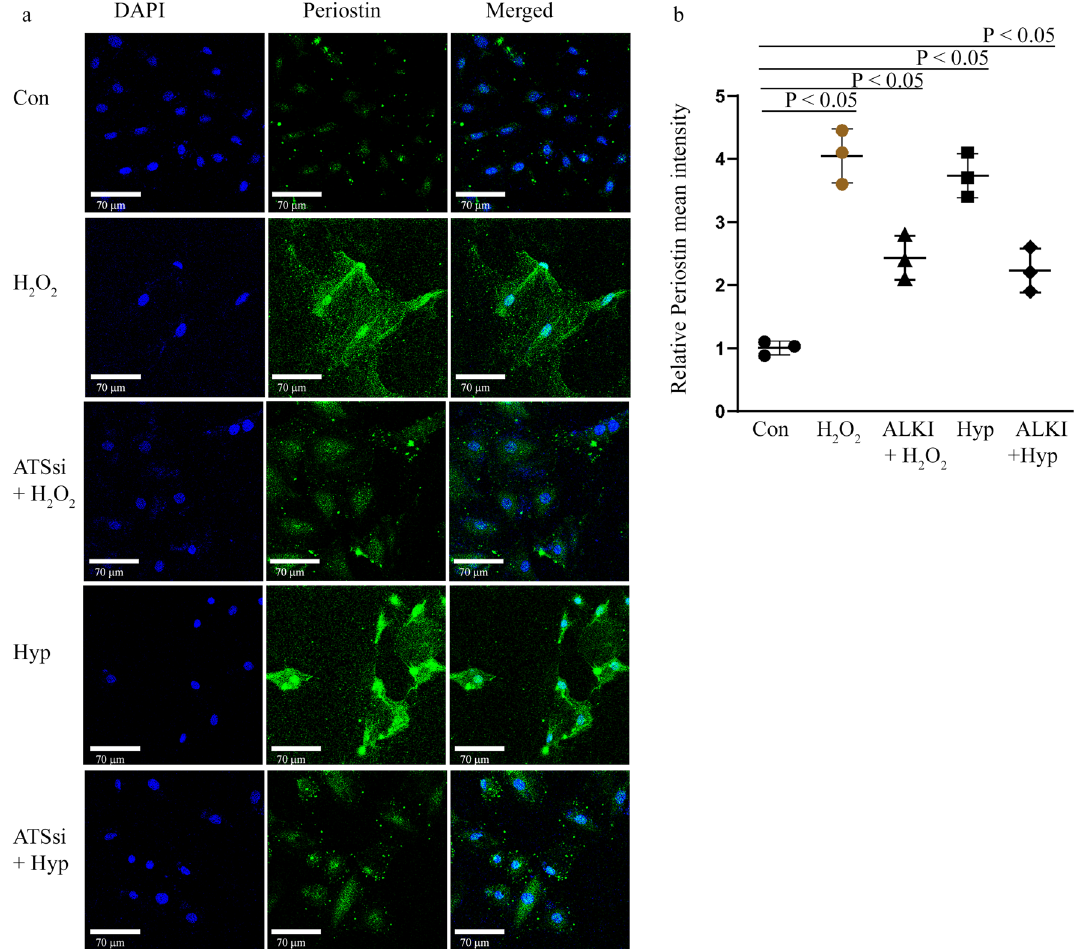
Figure 9. Reduced expression of Periostin following Adamts4 loss of function. IF with anti-Periostin antibody (shown in green colour) shows a fold change of 4 and 3.7 increase in the H 2 O 2 and Hyp treated group in comparison to the control set, this elevation is significantly reduced 2.4 and 2.2 in ATSsi + H 2 O 2 and ATSsi + Hyp groups following siRNA mediated knockdown of Adamts4 ( a ). DAPI (shown in blue) was used as nuclear stain. Its quantification is depicted in the graph ( b ). n = 3, data analysed and expressed as mean ± SD. Differences were considered statistically significant for p <